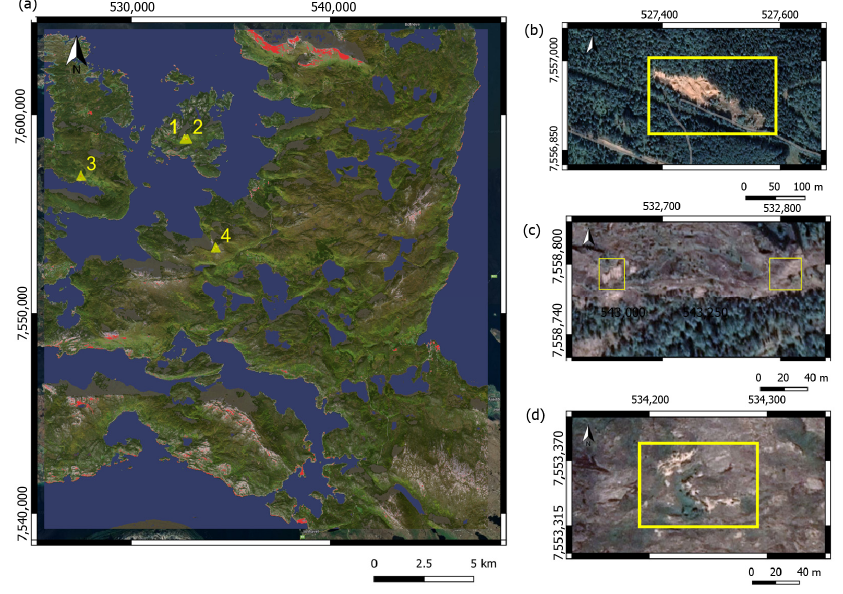
Figure 23. Points of interest for exploration. ( a ) Overview of the study area where the points of interest were identified by the yellow rectangle. ( b ) Points 1 and 2 in focus. ( c ) Point 3 in focus. ( d ) Point 4 in focus.